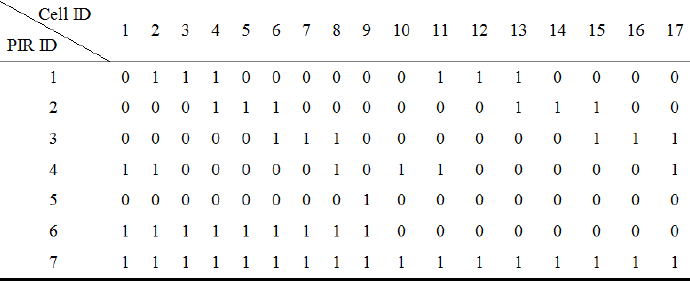
Figure 2. Measurement matrix: seven pyroelectric infrared (PIR) sensors for 17 sampling cells.